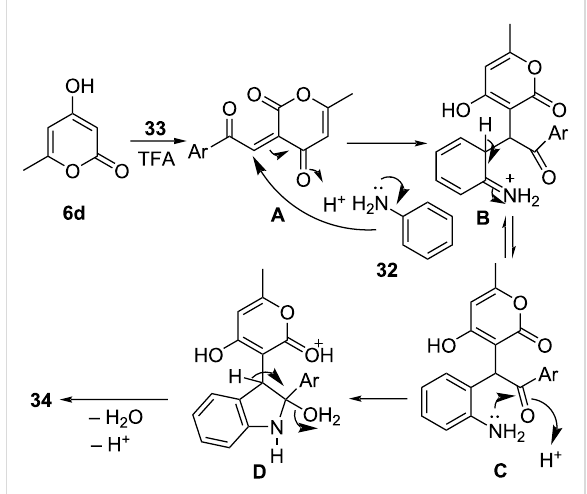
Scheme 11: Plausible mechanism for the synthesis of functionalized